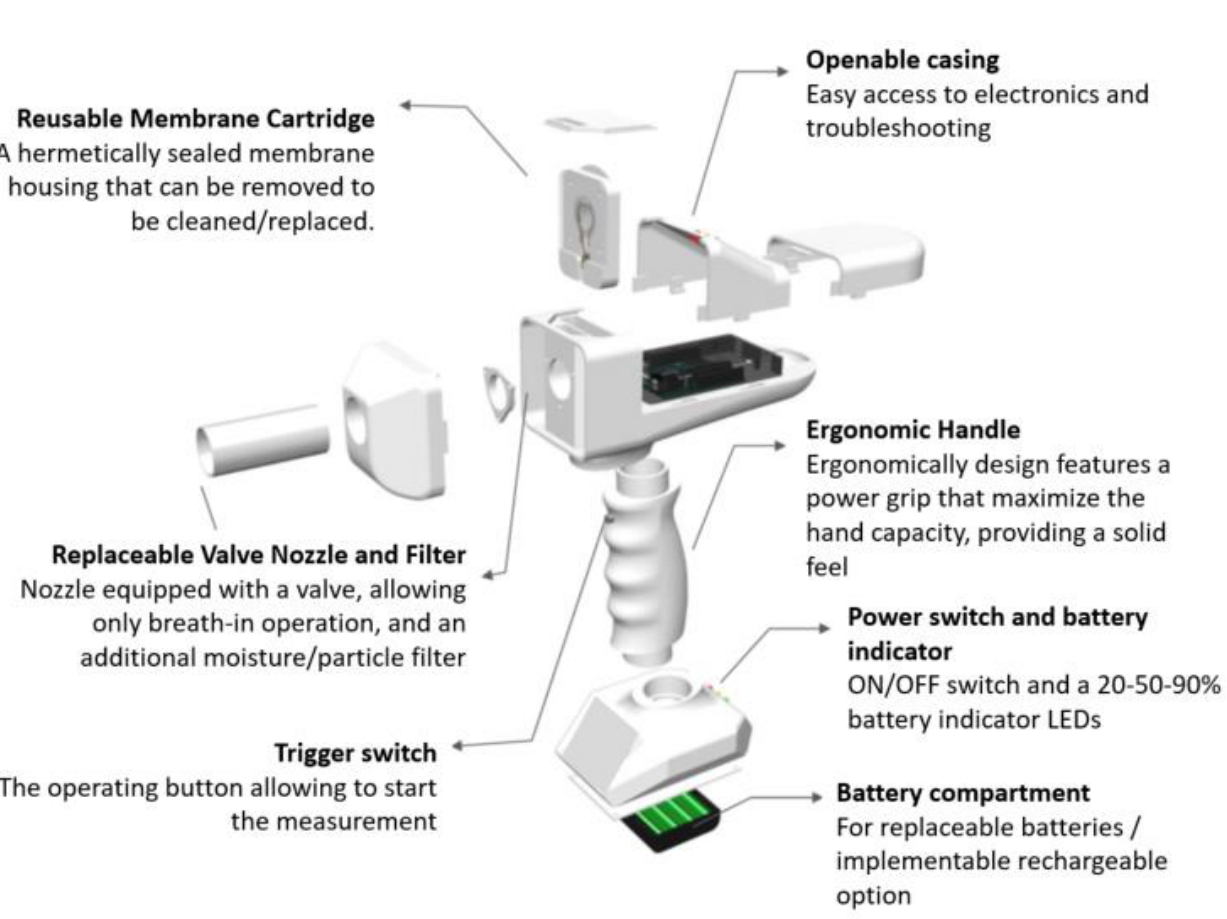
Figure 7. Overview of the breathalyzer prototype with sensing elements, electronics, microprocessor and mechanical casing.